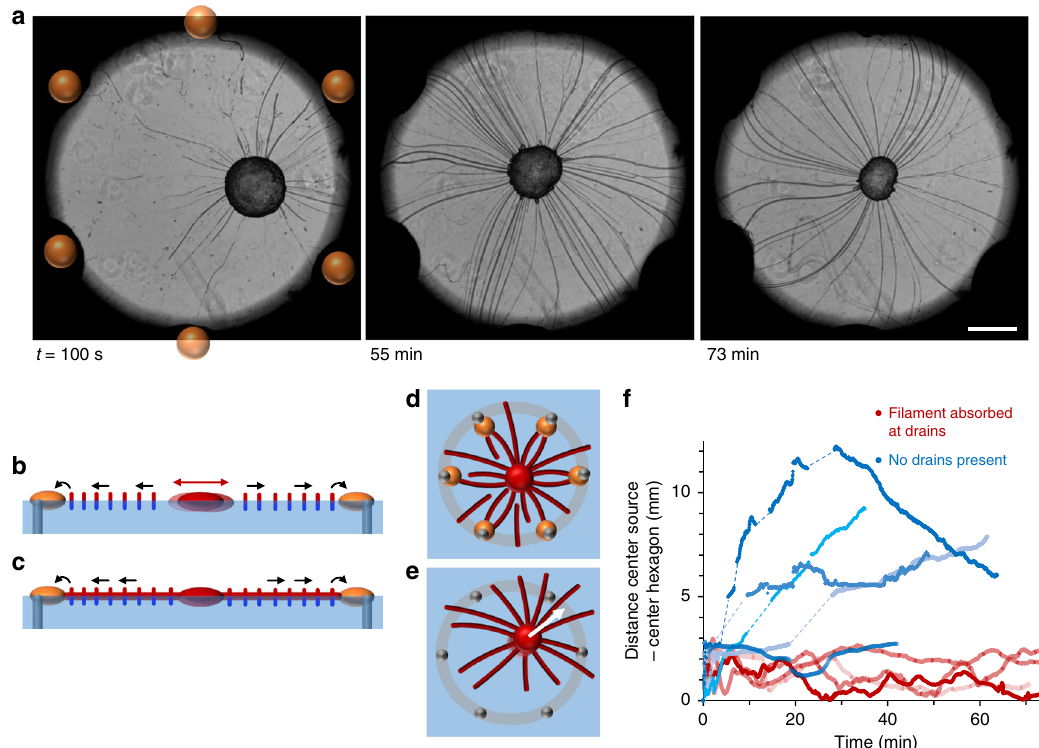
Fig. 4 Autonomous positioning of dynamic assemblies in a ring of drain droplets. a Optical microscopy recording of a free- fl oating source droplet self- positioning in between six drain droplets that were placed at the tips of hexagonally positioned pins — as indicated by the orange spheres at t = 100 s. b , c Schematic representation of the process: The Marangoni fl ow towards the drains moves the source droplet around ( b ), and drags the fi laments towards the drains ( c ). ( d ) Upon tethering to the drains, the fi laments stabilize the positioning of the source droplet. e In the absence of drain droplets, the source droplet moves around randomly within or outside the hexagon. f Time-dependent distance between the source droplet center and the hexagon center. The red curves correspond to the experiments shown in a and Supplementary Fig. 7, conducted under similar conditions; the blue curves correspond to experiments conducted without drain droplets (Supplementary Fig. 8). The scale bar represents 1 mm.